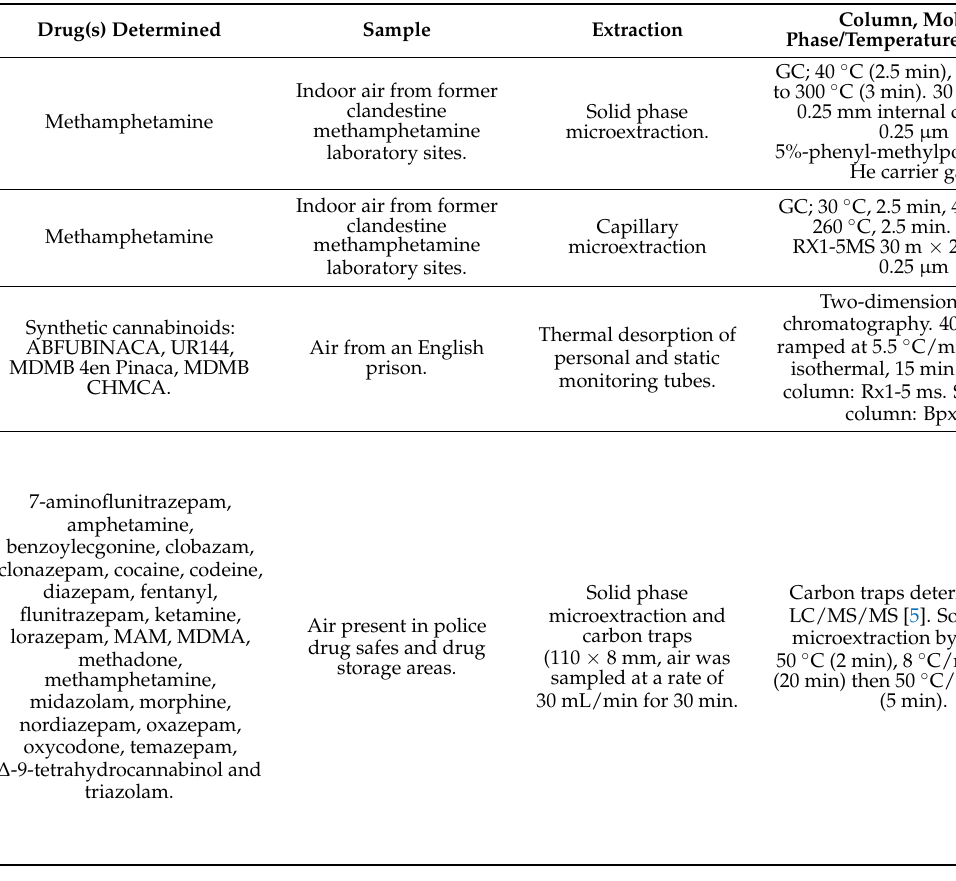
Table 1. Determination of air concentrations of psychoactive